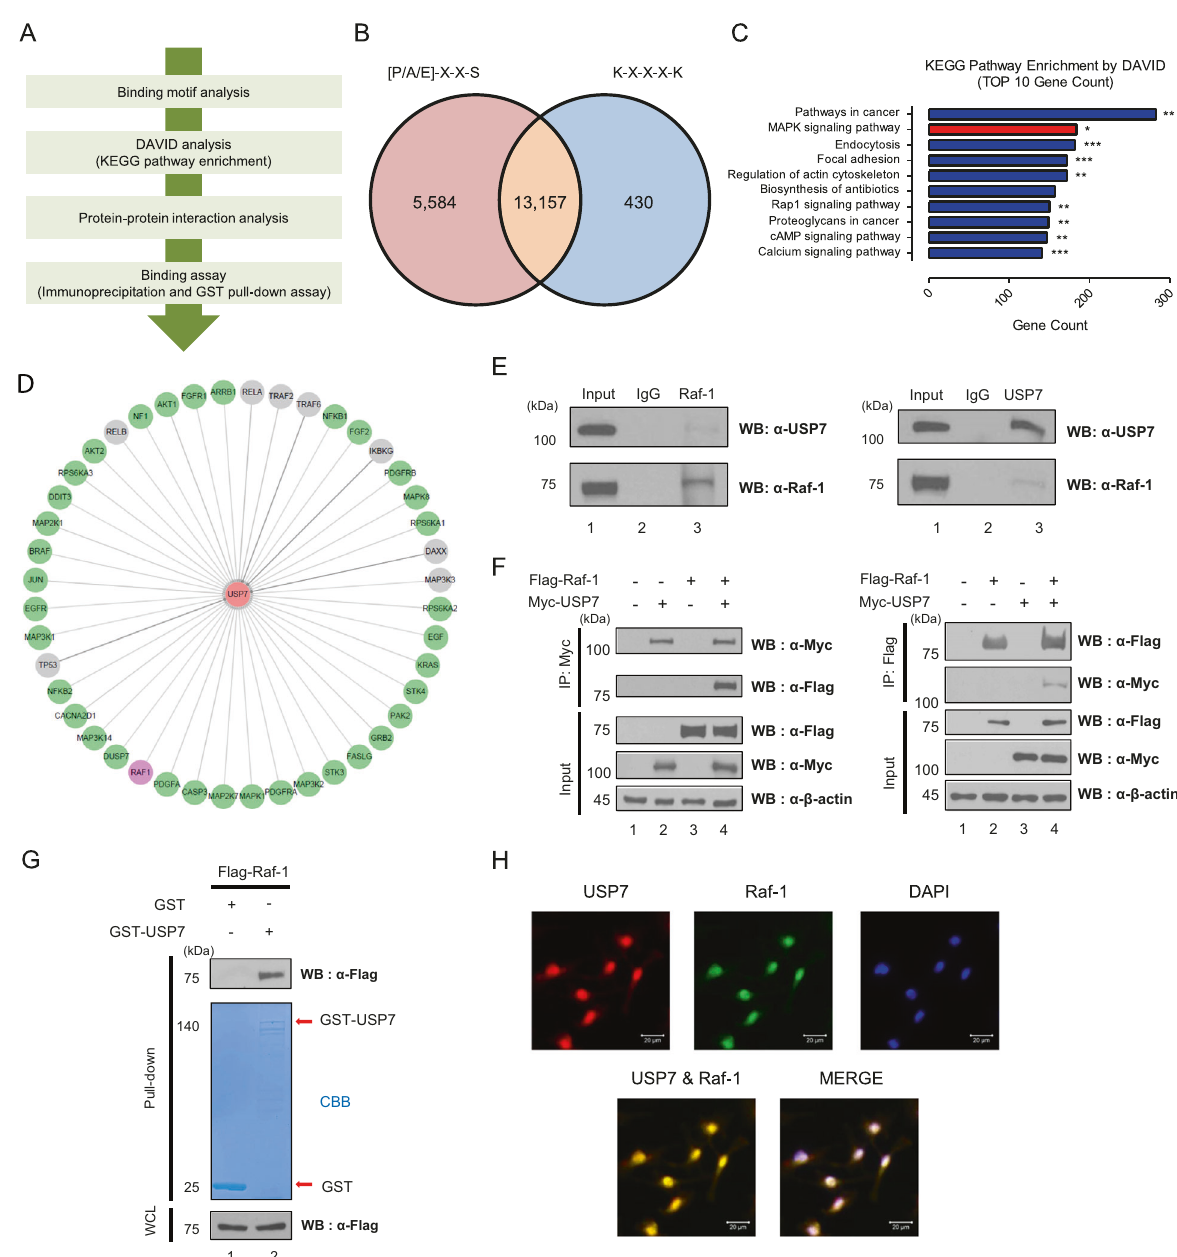
Fig. 1 Motif analysis for identifying new binding partners of USP7. A Schematic overview of the work fl ow for identifying new binding partners of USP7 using binding motifs, DAVID, protein-protein interaction, and binding analyses. B The diagram shows the number of proteins having each or both [P/A/E]-X-X-S and K-X-X-X-K motifs. C Pathway enrichment of putative substrate proteins of USP7 was analyzed by DAVID analysis. Y-axis indicates the pathway name, and X-axis indicates gene count in the pathways, and the asterisk indicates the p -value (* p < 0.05, ** p < 0.01, *** p < 0.001.) D Interaction network between USP7 and putative substrates with high interaction score and with or without the connection revealed. The color of nodes indicates the con fi rmation of binding between USP7 and proteins (Gray: published and green: nonpublished), and Raf-1 binding with USP7 is shown in purple. Interaction network is shown by Cytoscape. E Endogenous USP7 or Raf-1 was precipitated with an anti-USP7 or an anti-Raf-1 antibody in HeLa cell lysate. F HEK293T cells were transfected with Myc- USP7 , and Flag- Raf-1 and immunoprecipitations were performed by an anti-Myc or an anti-Flag antibody. G Puri fi ed GST- or GST-USP7 expressed in BL21 was incubated with Flag- Raf-1 -overexpressed HEK293T cells. GST- or GST-USP7 was pull downed by GST bead and gel was stained by Coomassie Brilliant Blue. H Immunocytochemical analysis was performed to investigate the localization of respective USP7 and Raf-1, and co-localization of USP7 and Raf-1. database (https://thebiogrid.org/), we exclude the proteins pre- Using the gene information belonging to the MAPK signaling viously known to bind USP7 [38]. The interaction network was pathway organized by DAVID analysis, we narrowed down the drawn using a Cytoscape (Fig. 1D). Among the putative substrate putative substrate proteins of USP7 by protein-protein interaction proteins, Raf-1 is a serine/threonine kinase essential for signal (PPI) analysis in the STRING database [37]. We only selected the transduction from Ras to MEK1/2 in the MAPK signaling pathway. edge connected to USP7, and using the BioGRID interaction